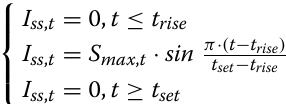
The model is characterized by the peak solar radiance S max , t (kW/m 2 ), the sunrise t rise and sunset t set times. More precisely: